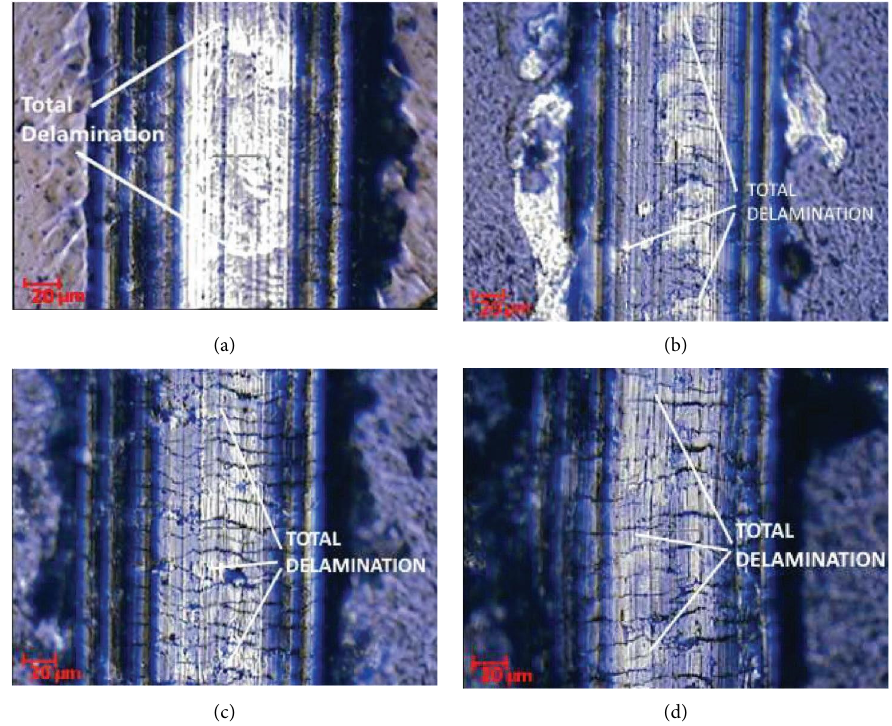
Figure 6: Scratch test micrography of DLC WC:C (a), ASPN 350 ° C +DLC (b), ASPN 400 ° C +DLC (c), and ASPN 450 ° C +DLC